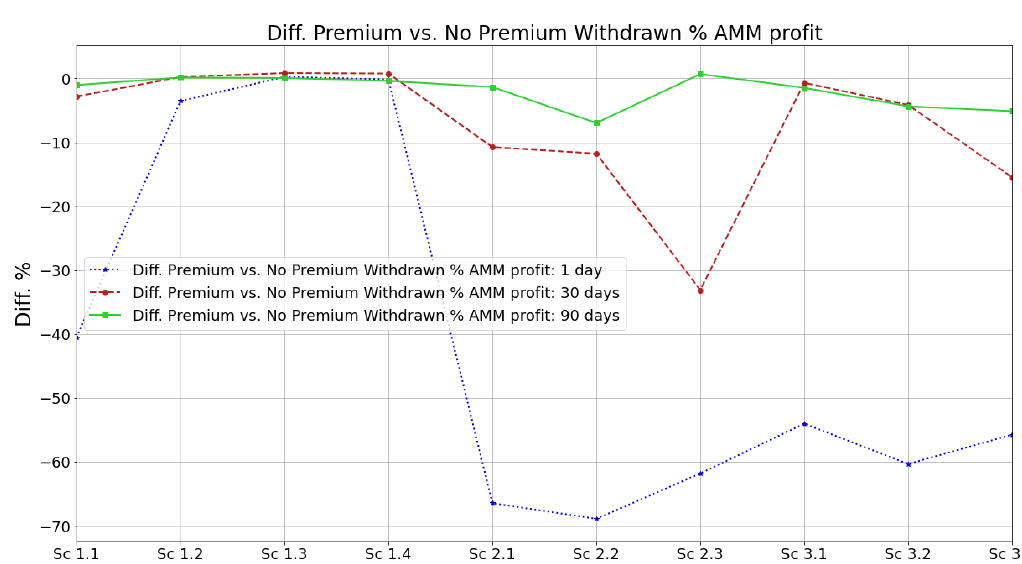
Figure 5. Premium vs. No Premium Withdrawn rkAMM profit absolute values.